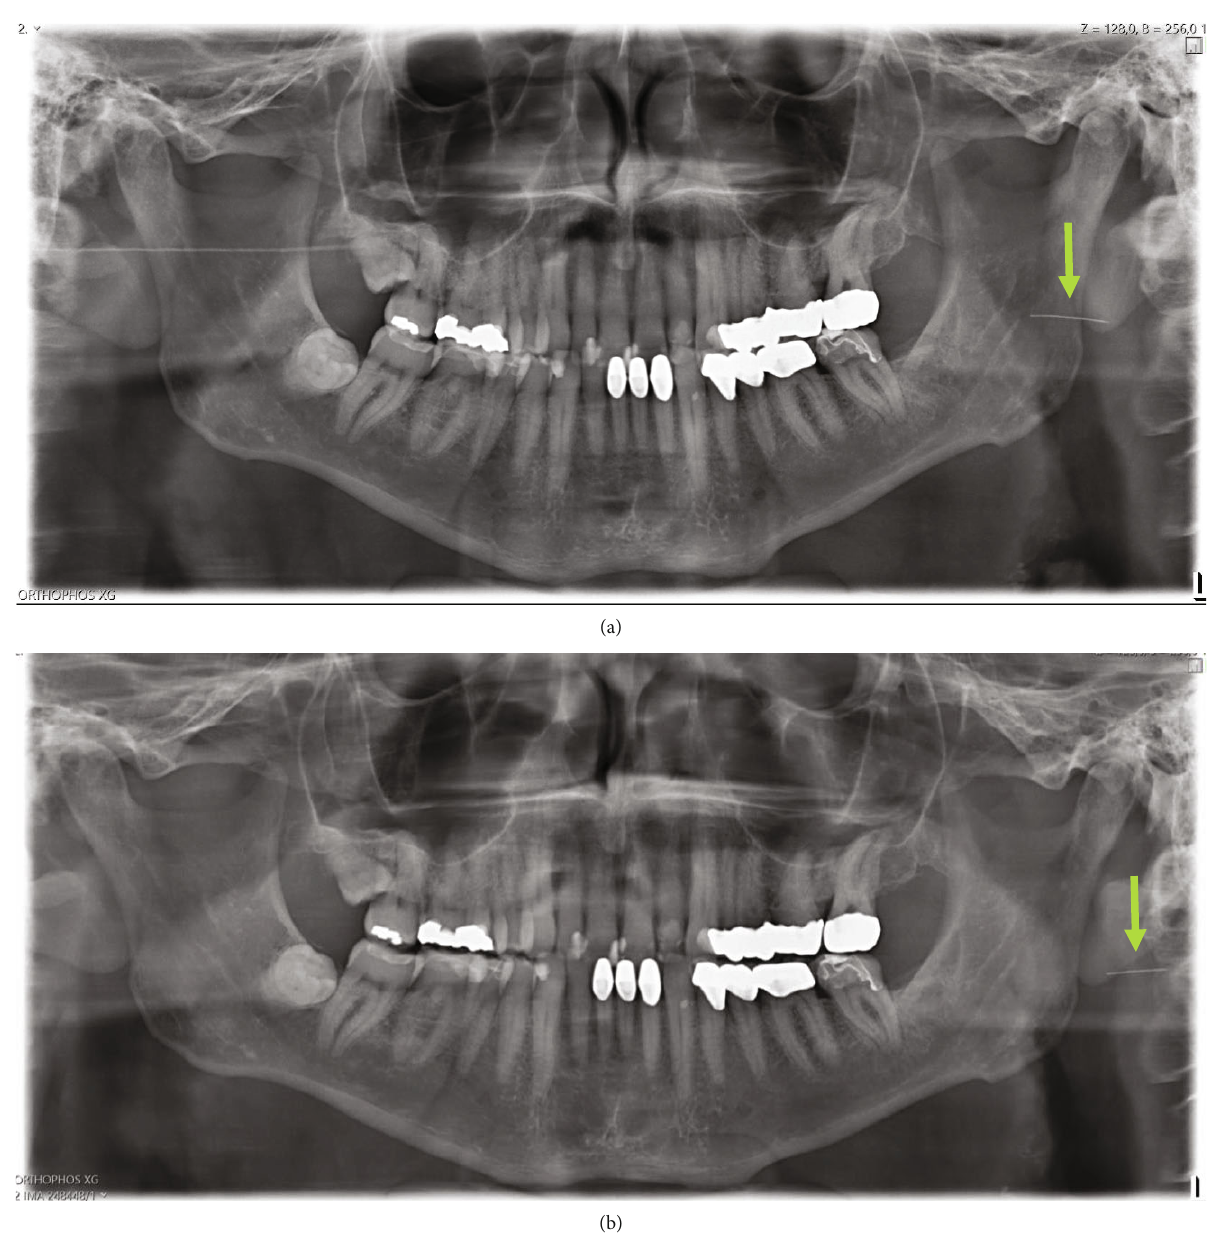
Figure 1: Orthopantomographic images on the day of initial presentation (a) and one day afterwards (b). The dislodged fractured hypodermic needle is located at the left ascending mandibular ramus and moved by about 1.5cm after one